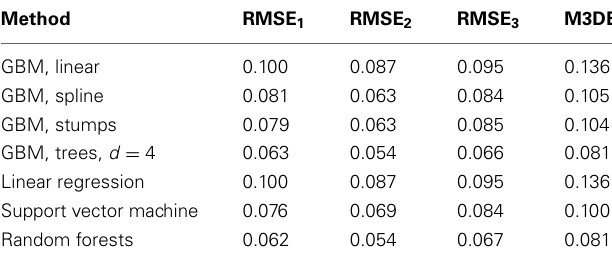
Table 1 | Machine learning algorithm